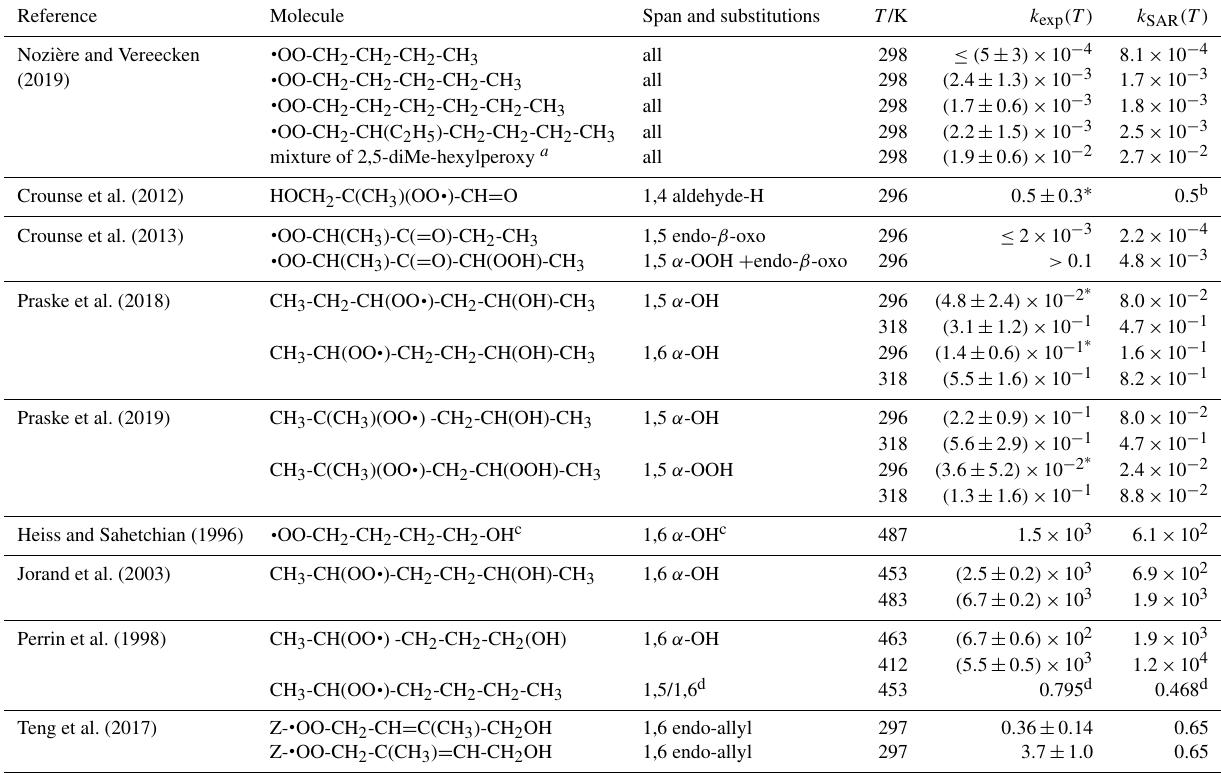
Table 9. Comparison of the SAR predictions, k SAR (T ) , against the experimental values, k exp (T ) . Values marked with an asterisk are used in the derivation of the SAR, usually by geometric averaging with theoretical